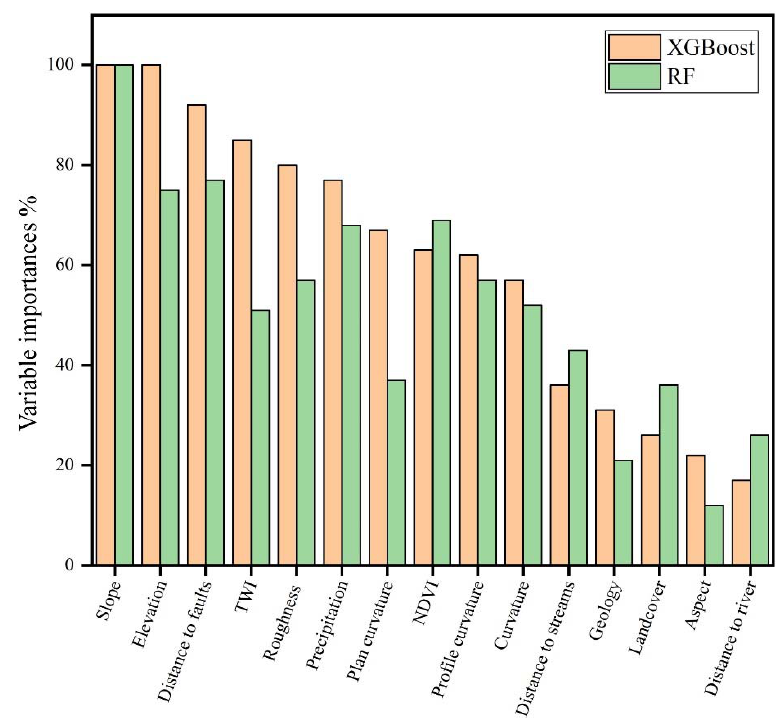
Figure 7. Variable’s importance in the research